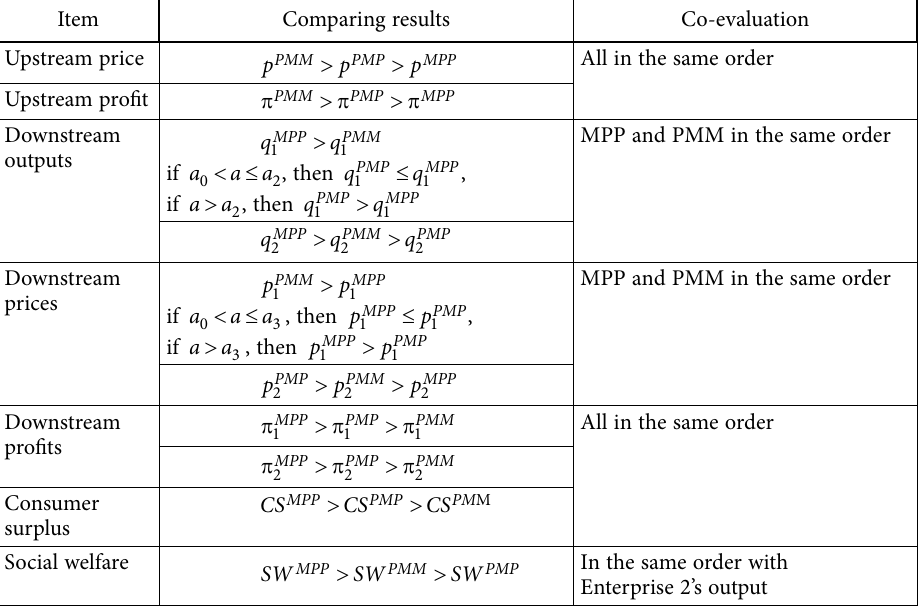
Table 1. Comparing results of the MPP, PMM, and PMP models Comparing